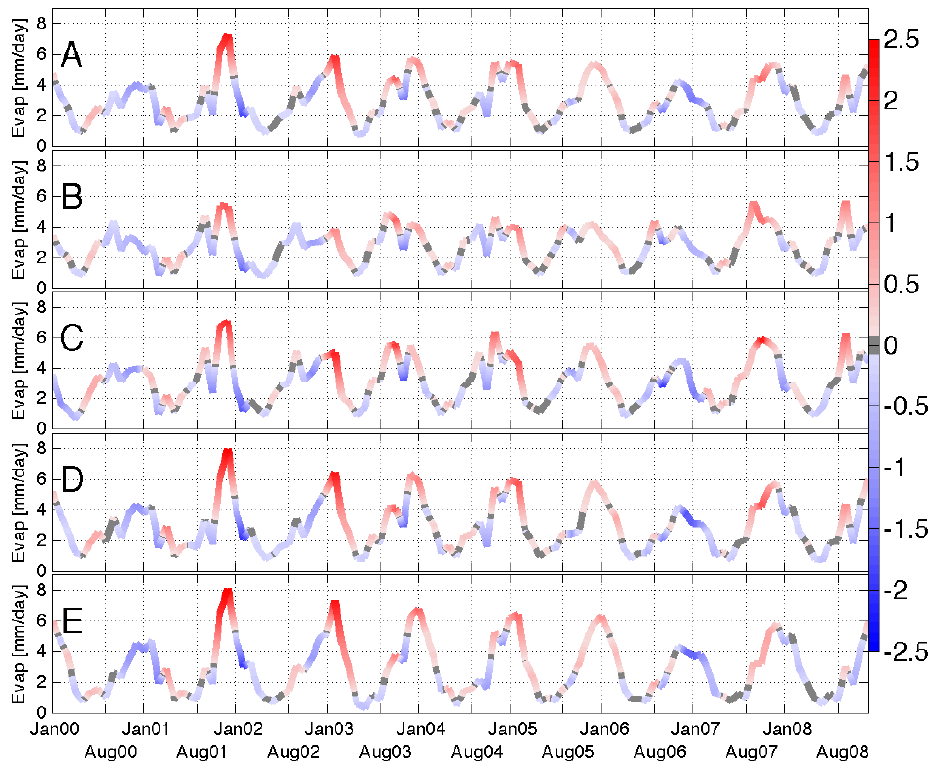
Fig. 4 Monthly time series of Evaporation rate, units are mm/day. Colour indicates monthly Fig. 4. Monthly time series of Evaporation rate, units are mmday − 1 . Colour indicates monthly anomaly values. (A) : whole Adriatic Sea; anomaly values. A: whole Adriatic Sea; B: WACC region; C: Northern Adriatic Region; D: Middle (B) : WACC region; (C) : Northern Adriatic Region; (D) : Middle Adriatic Region; (E) : Southern Adriatic Adriatic Region; E: Southern Adriatic Region.